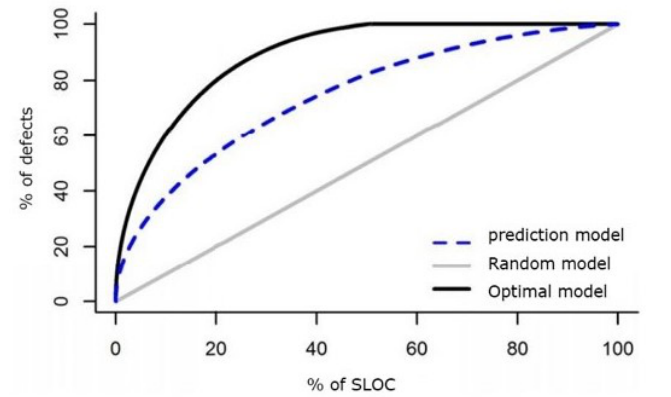
Figure 2. A SLOC-based cumulative lift